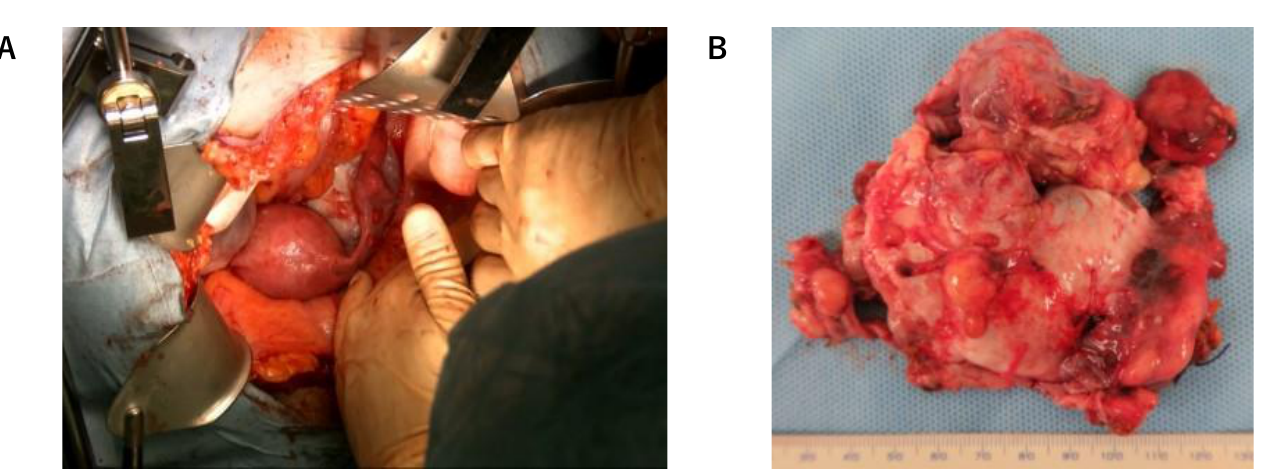
Figure 2. ( A ) Left ovarian tumor at laparotomy; ( B ) Resected tumor.